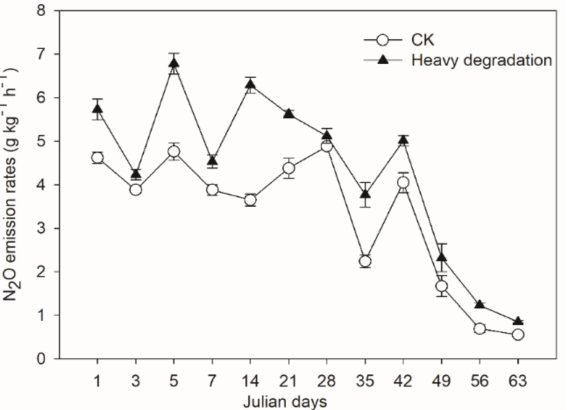
Figure 2. N 2 O emission rates in heavily degraded and control meadows from 1 to 63 days of